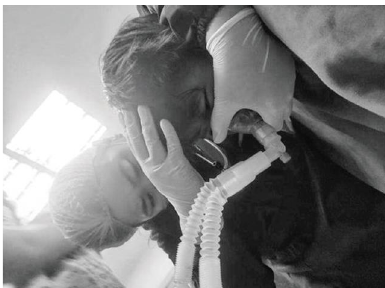
Figure 3: Preoxygenation is followed by a modifed rapid-sequence induction using a one-handed technique.